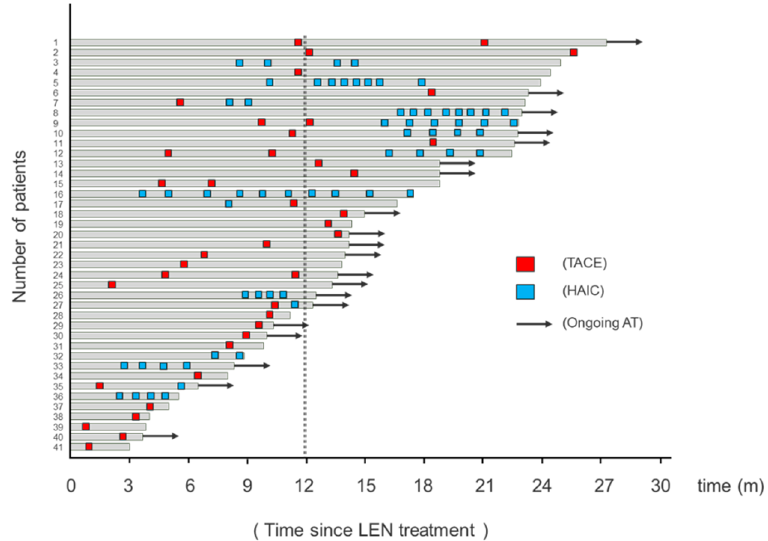
Figure 2. Swimmer plot of assessment by investigator assessment with alternating LEN and trans- arterial therapy (AT). Red squares indicate trans-arterial chemoembolization (TACE) treatment, and blue squares indicate hepatic arterial infusion chemotherapy (HAIC). Arrows indicate ongoing AT. The black dotted line indicates 12 months from the beginning of lenvatinib (LEN) administration.